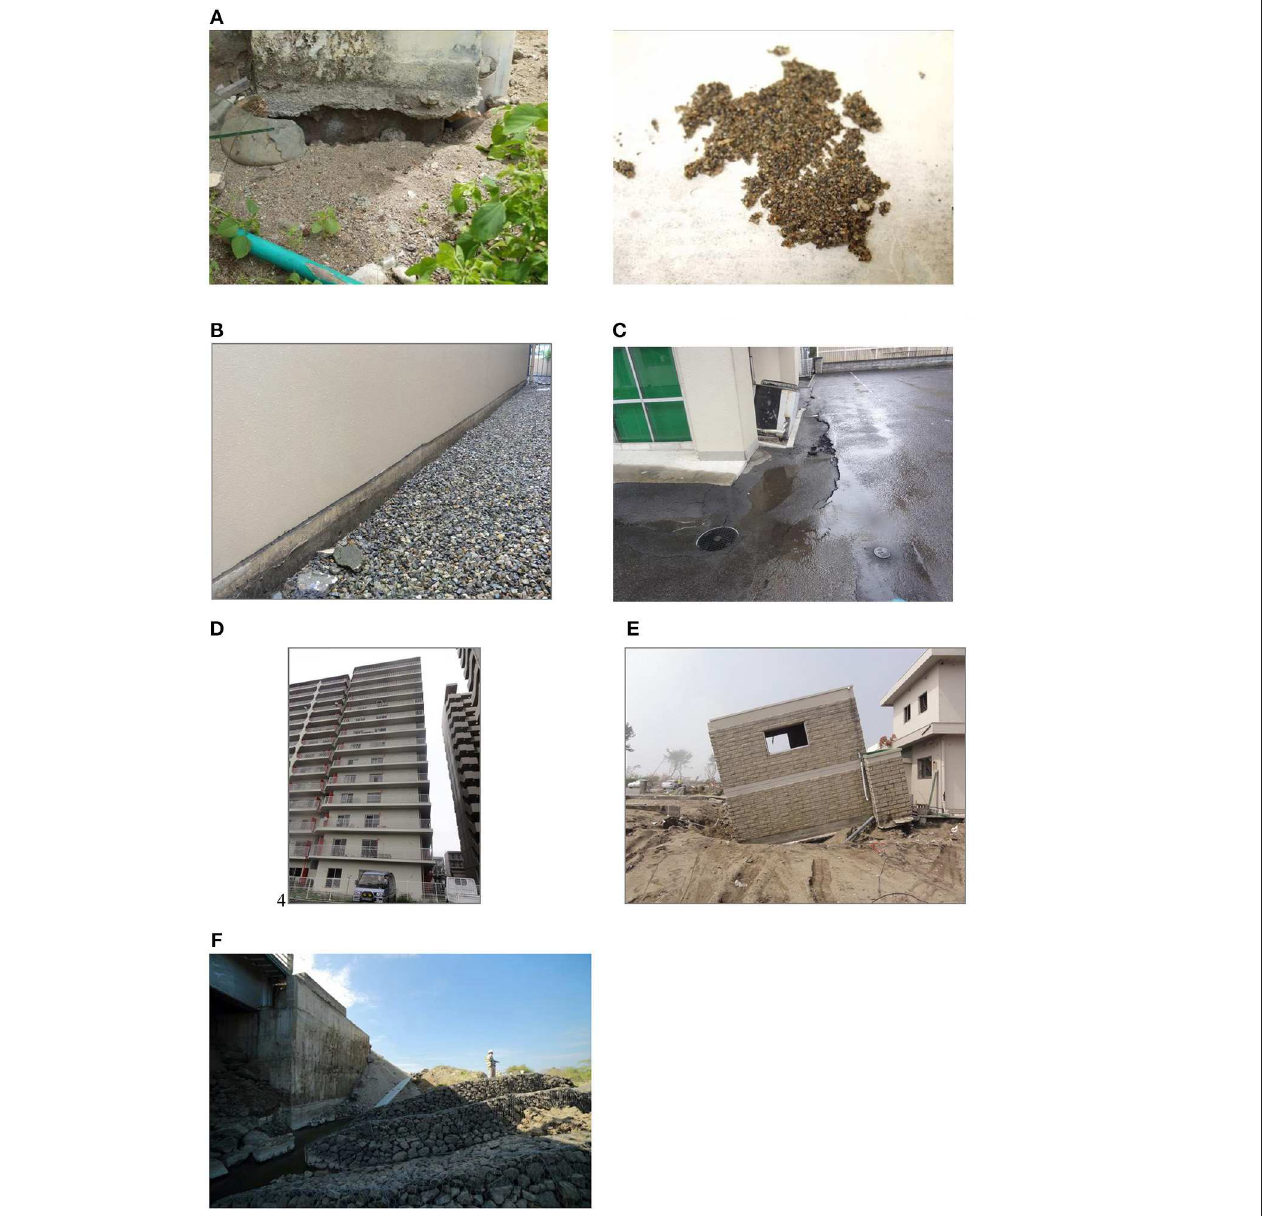
FIGURE 12 | Foundation and ground failures following Padang, Tohoku and Muisne earthquakes. (A) Settlement of ground around column where sand was found in the proximity. (B) Ground settlement around building at Sendai. (C) Sinking of building relative to surrounding at Sendai. (D) building tilt due to differential settlement at Sendai. (E) loss of soil bearing due to scour at sendai. (F) settlement and rotation of gabions on the river bank Mejia bridge.